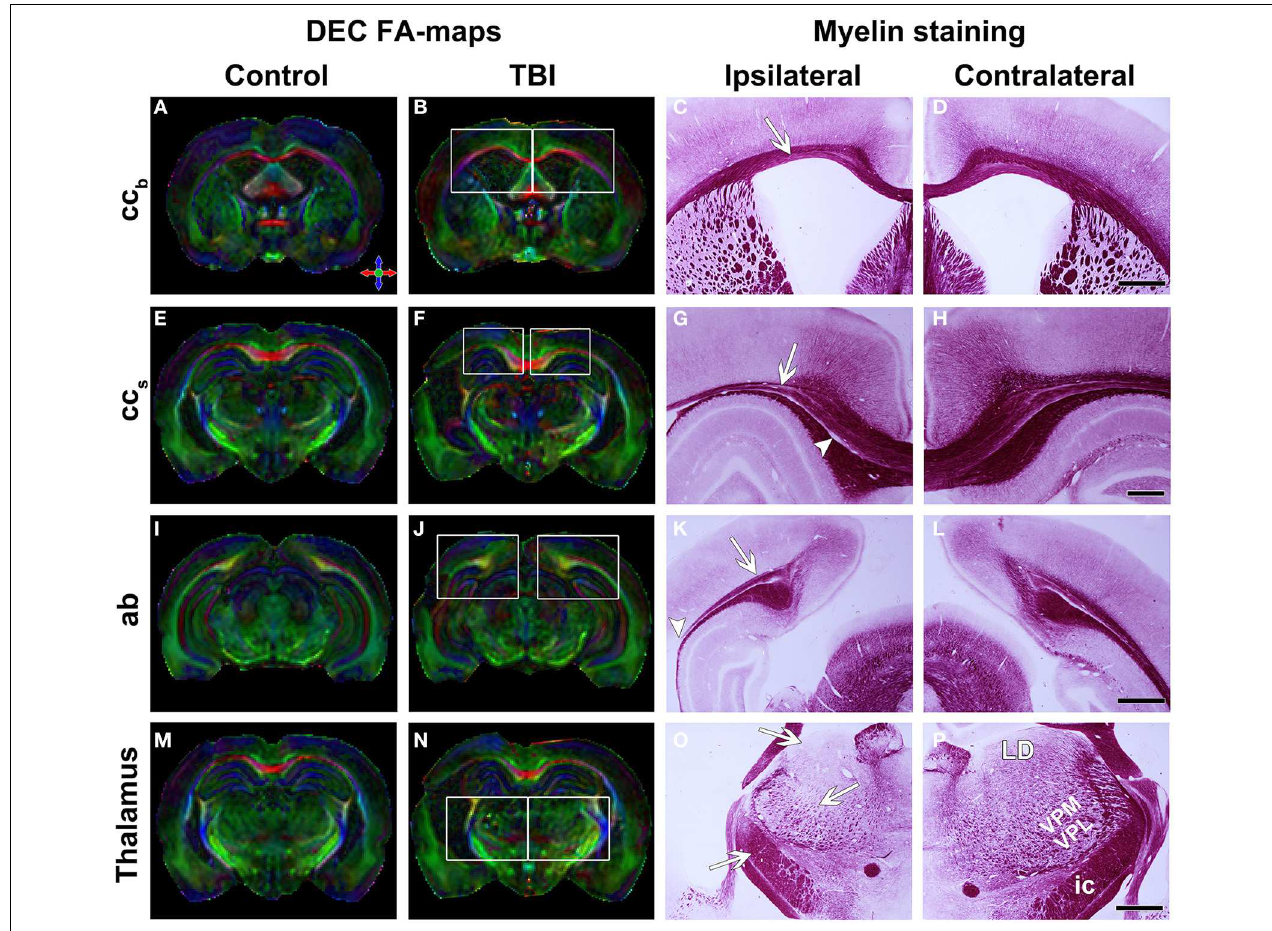
FIGURE 2 | Directionally encoded color (DEC) FA-maps of a sham-operated (A,E,I,M) and a TBI (B,F,J,N) animal. White squares indicate regions in the photomicrographs of myelin staining. Color coding in (A) red medial-lateral, green , rostral-caudal and blue dorsal-ventral. Representative photomicrographs of myelin-stained sections of the ipsilateral (C,G,K,O) and contralateral (D,H,L,P) hemisphere of a TBI animal. Panels (A–D) show the body of the corpus callosum. White arrow indicates the thinning of this structure. Panels (E–H) show the splenium of the corpus callosum with thinning of the structure (white arrow) and loss of myelinated axons (white